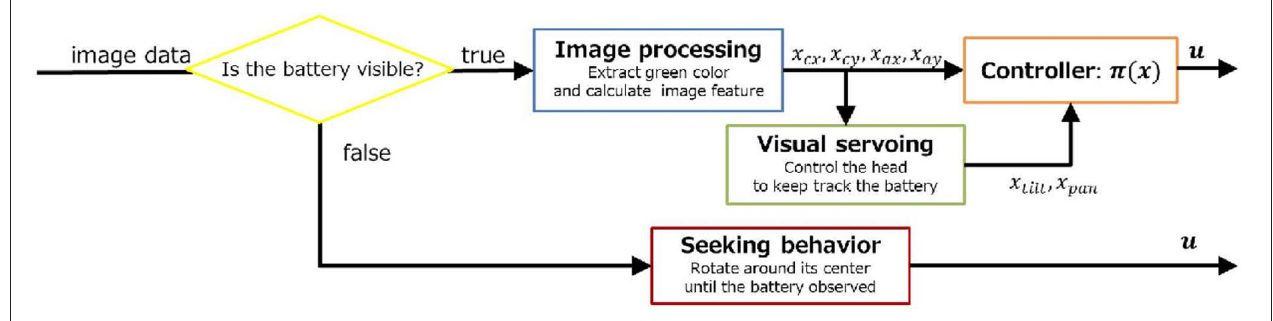
FIGURE 3 | Control diagram in the Spring Dog.